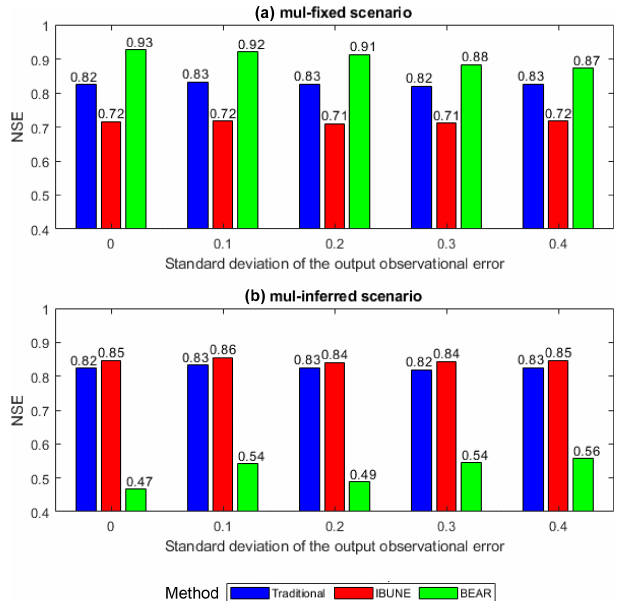
Figure 3. Comparison of the Nash–Sutcliffe efficiency (NSE) of the modified input vs. the true input under the interference of the output observational errors, with the increasing standard deviations in two calibration scenarios in the synthetic case 2 (including mul-fixed and mul-inferred; notations are given in Table 2) via three calibra- tion methods (including the traditional method, the IBUNE method, and the BEAR method; their algorithms are explained in Sect.